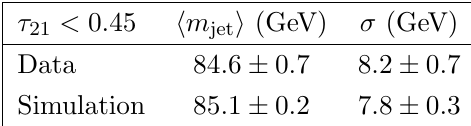
Table 2 . The W jet mass peak position and resolution, as extracted from top quark enriched data and from simulation. These results are used to apply corrections in the V tagging